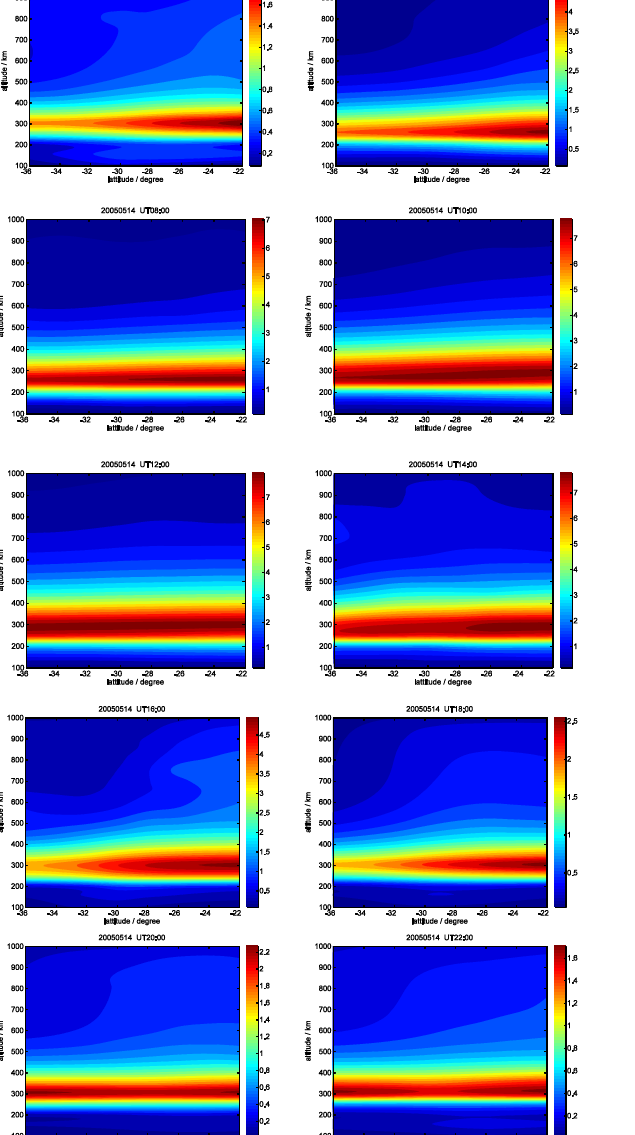
Figure 5 Map of the electron density changes on the 24°E profile from 04:00UT on 14May to 20:00UT on15 May (unit: 10 11 el/m 3